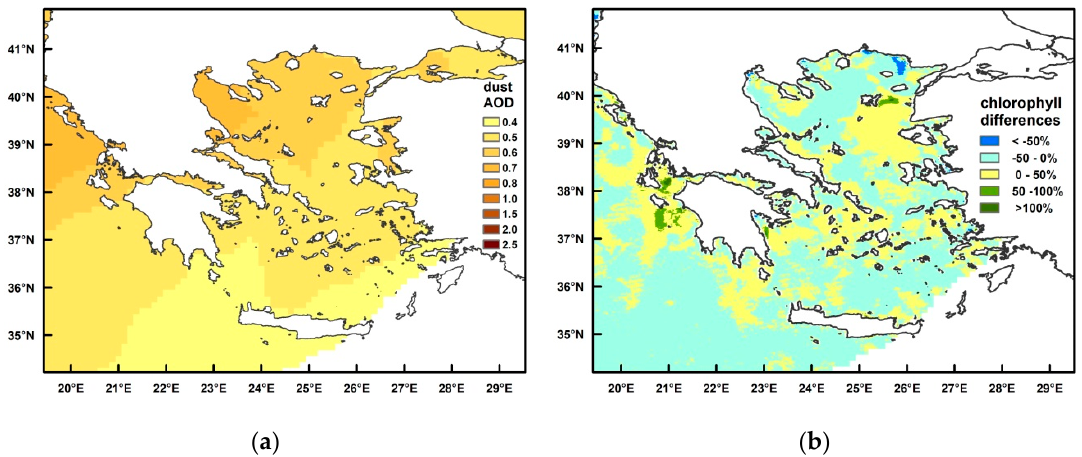
Figure 4. ( a ) Maximum dust AOD during the episode 18–21 June 2016; ( b ) Chl-a %